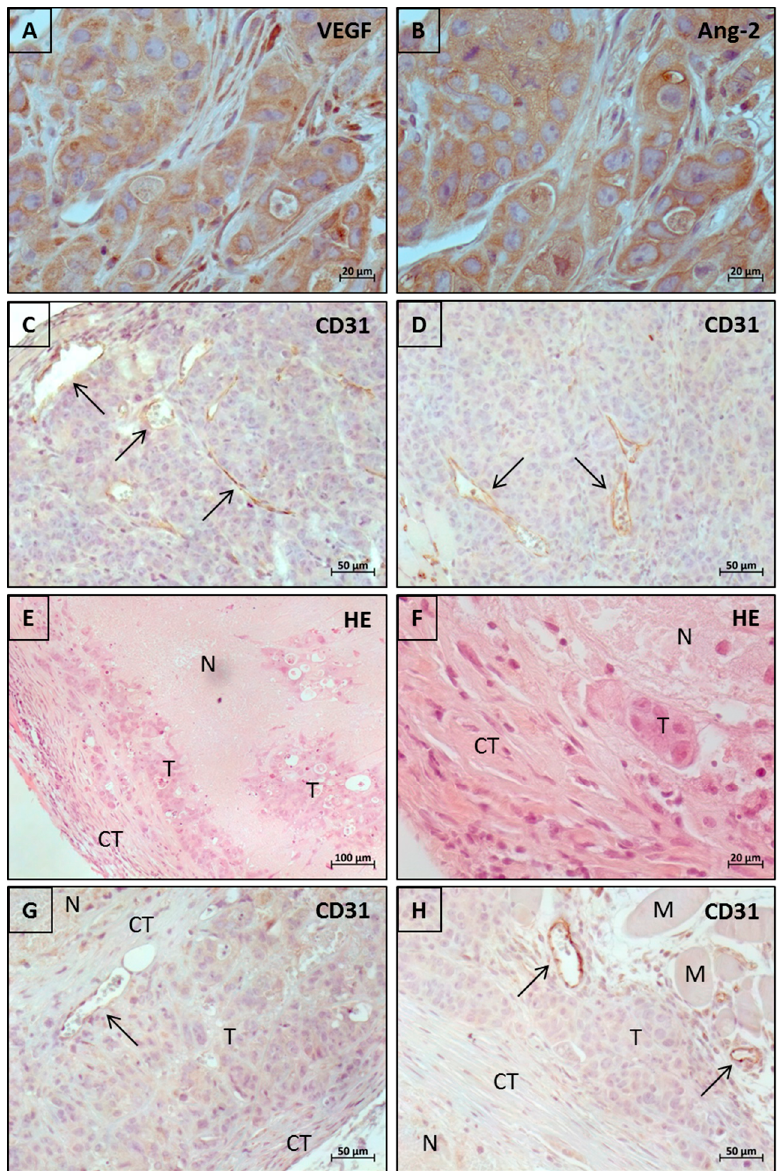
Figure 5. Histological examination of tumor tissues. ( A and B ) Staining of VEGF and Ang-2 shows cytoplasmic localization in tumor cells and stromal cells (magnification 400×). ( C ) CD31-positive vessel structures with typical pattern throughout vital tumor tissue and at the periphery (upper left) from a tumor of control group (magnification 200×). ( D ) Normal CD31-positive vessel formation within vital tumor tissue in a CrossMab treated, initially retarded and later progressive tumor (magnification 200×). ( E ) Representative example of a complete retarded tumor showing massive intratumoral necrosis surrounded by layers of vital tumor cells and connective tissue with avascular appearing tumor tissue islands (magnification 100×). ( F ) Peripheral area of the smallest tumor residue from the CrossMab/chemotherapy group showing a small tumor cell colony embedded in connective tissue (magnification 400×). ( G ) Peripheral area of a tumor residue from the CrossMab/chemotherapy group showing CD31-positive vessel structure located at the border between tumor tissue and an inner layer of connective tissue that separates the central necrotic area from the tumor tissue; the outer layer of connective tissue is seen lower right (magnification 200×). ( H ) Peripheral area of a tumor residue from the CrossMab/chemotherapy group showing CD31-positive vessels between muscle tissue from the mouse body and invading tumor tissue outside of the outer connective tissue layer of main tumor area. Note the colonizing tumor cells around marked vessels (magnification 200×). (N—necrotic area, T—tumor tissue, CT—connective tissue, M—muscle tissue; arrows points to CD31-positive vessel structures).